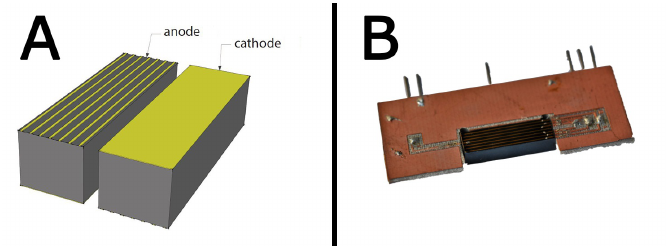
Figure 3. ( A ) 3D model of the drift strip detector; ( B ) actual CZT detector bonded to the intermediate electronic